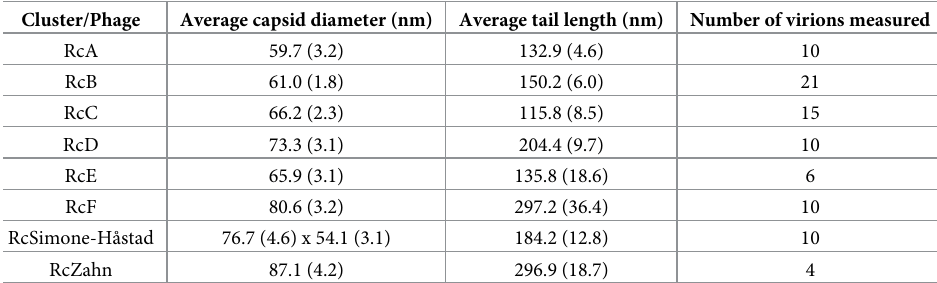
Table 1. R . capsulatus phage virion